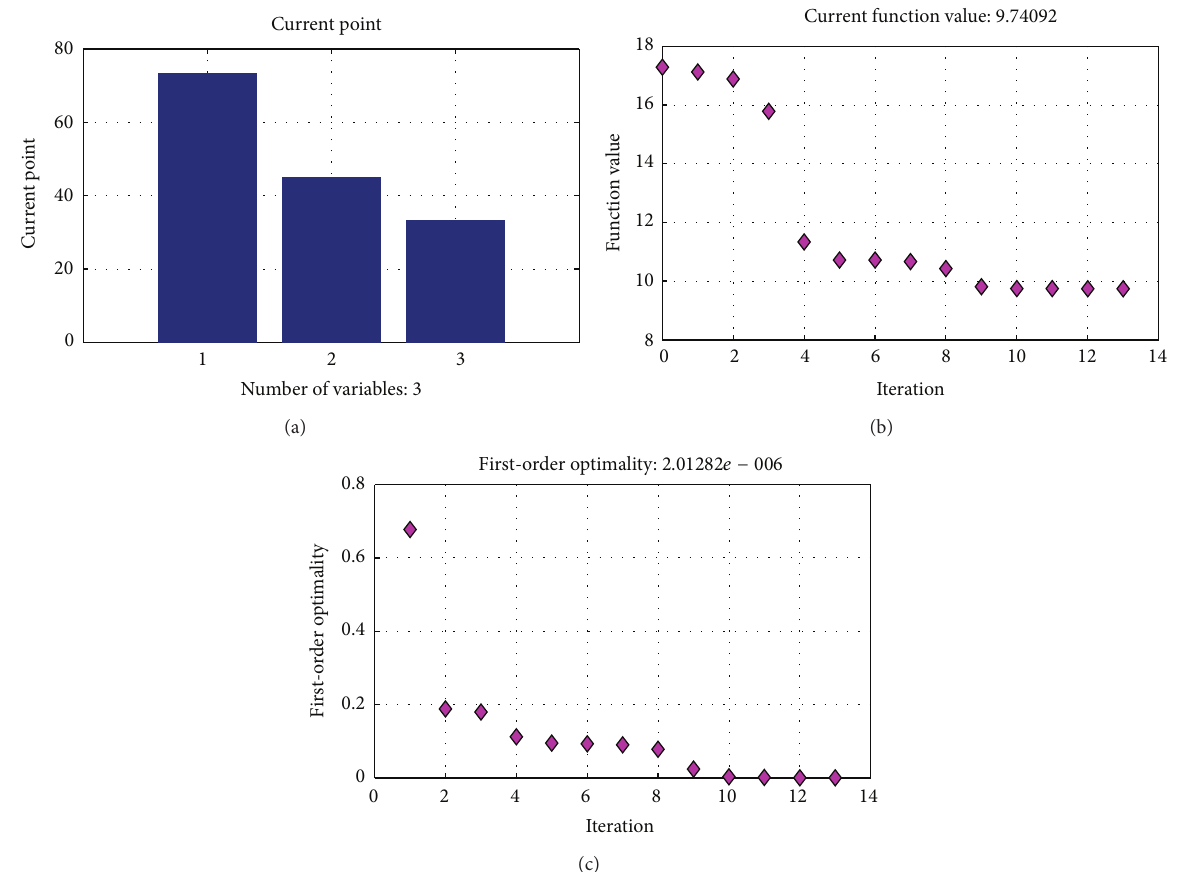
Figure 14: The Lagrange multiplier